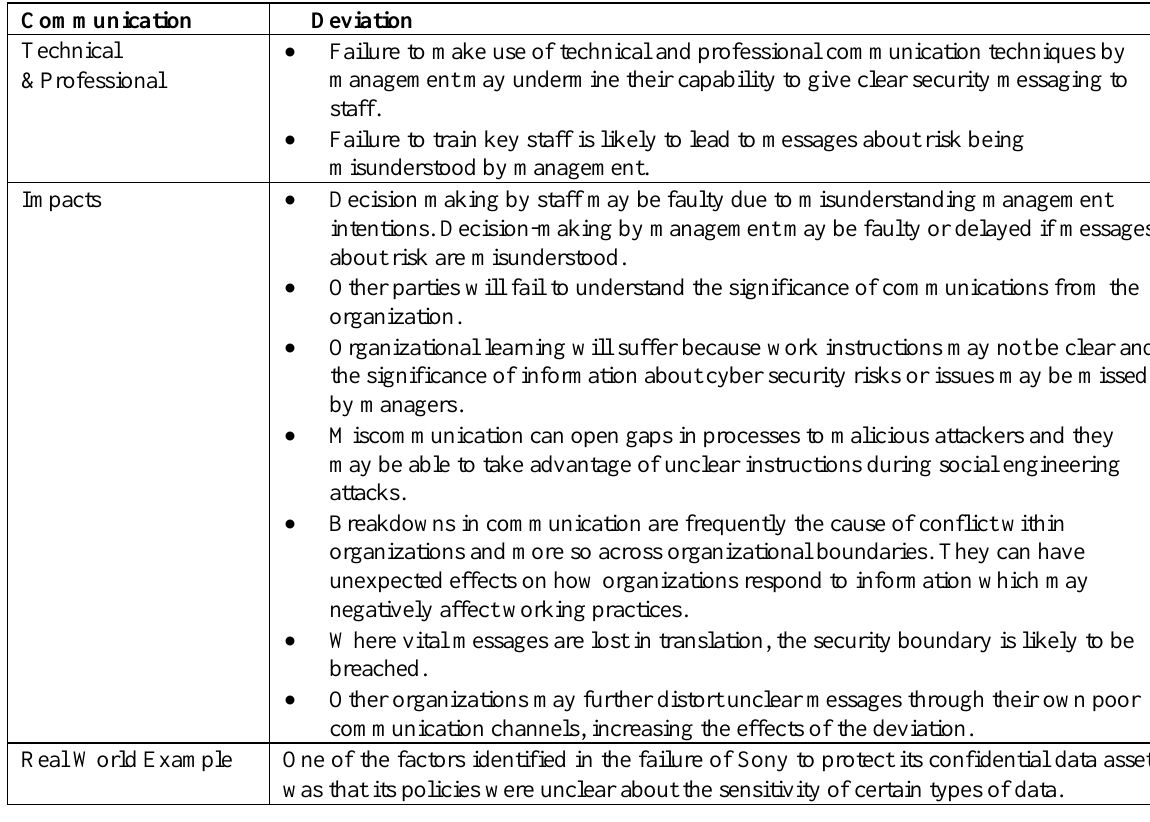
Table 4. Communication: